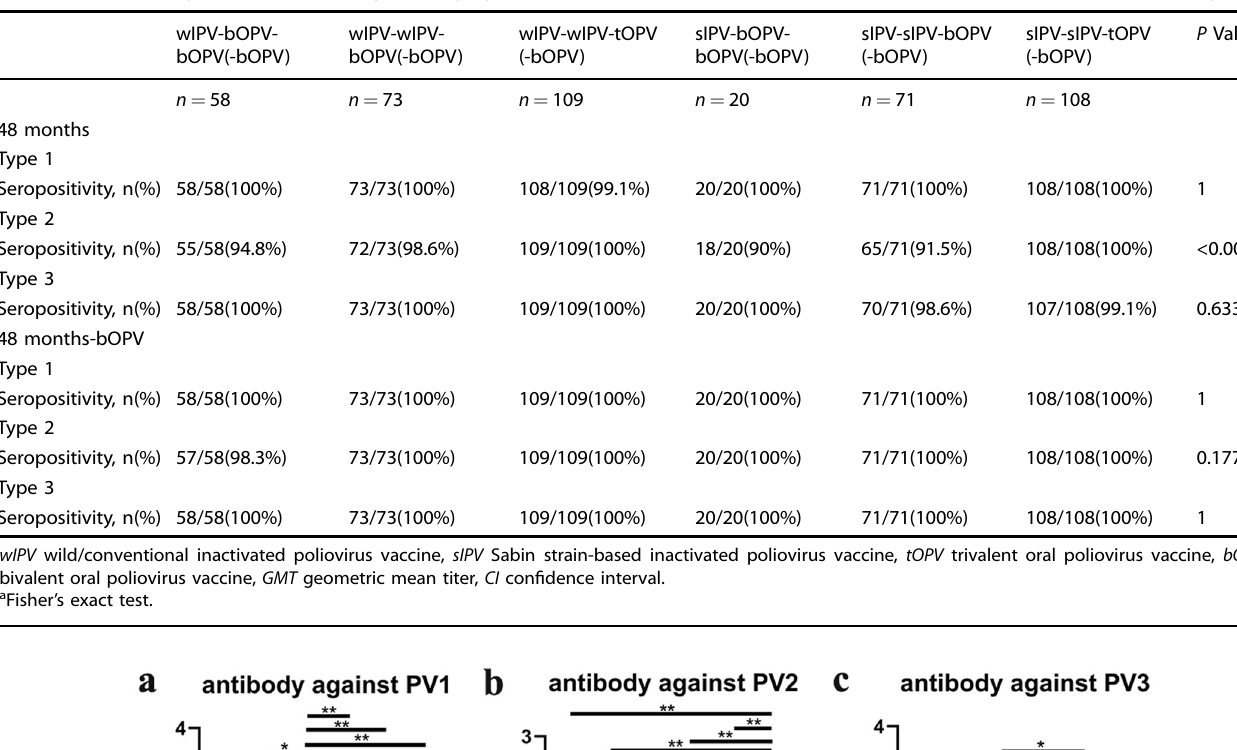
Table 3. Seropositivity rates for neutralizing antibody against PV1, PV2, and PV3 before and after booster immunization at 48 months of age.